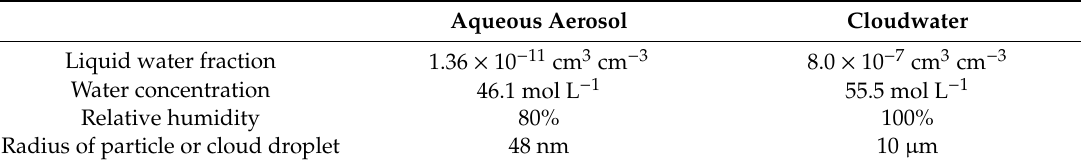
Table 1. Di ff erence in conditions for aqueous aerosol mode and cloudwater mode for this study in GAMMA